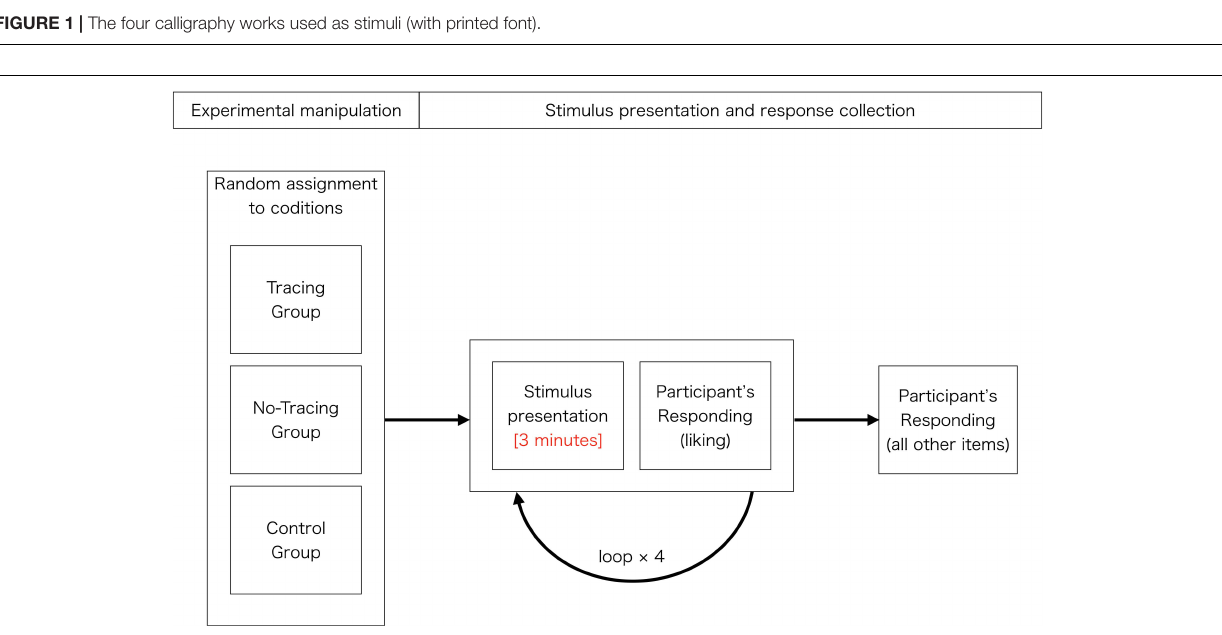
FIGURE 2 | The procedure of experiment in Study